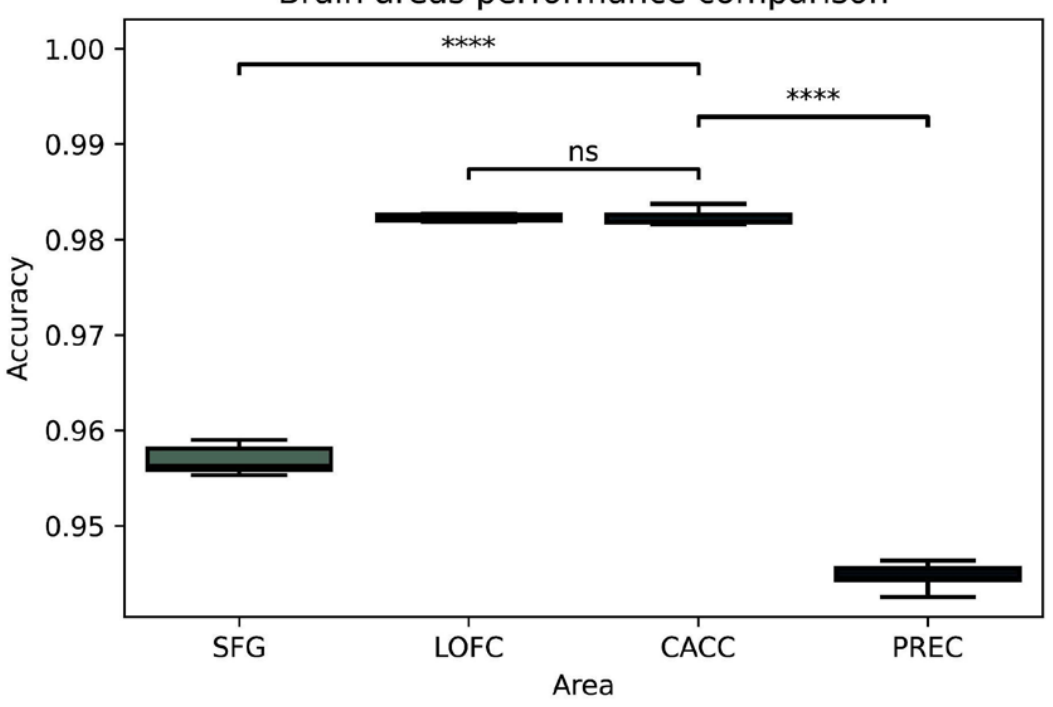
Figure 2. Accuracy comparison between brain areas associated with the electrodes at the lateral orbitofrontal cortex (LOFC), caudal anterior cingulate cortex (CACC), precuneus (PREC), and superior frontal gyrus (SFG). p -value annotation legend: ns: non-significant; **** p < 0.0001.